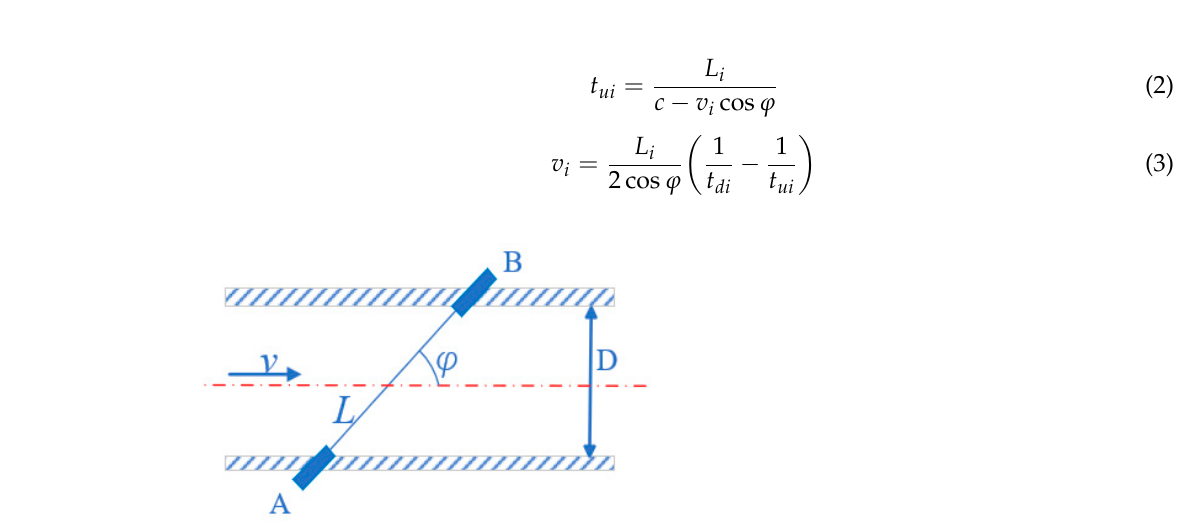
Figure 1. Working principle of transit-time multipath ultrasonic flowmeter (TM-USM).